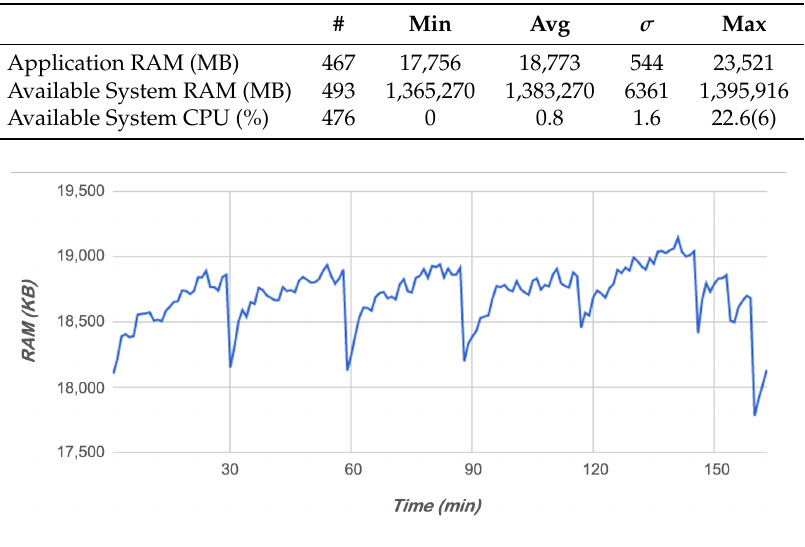
Figure 11. Device agent RAM usage over time.